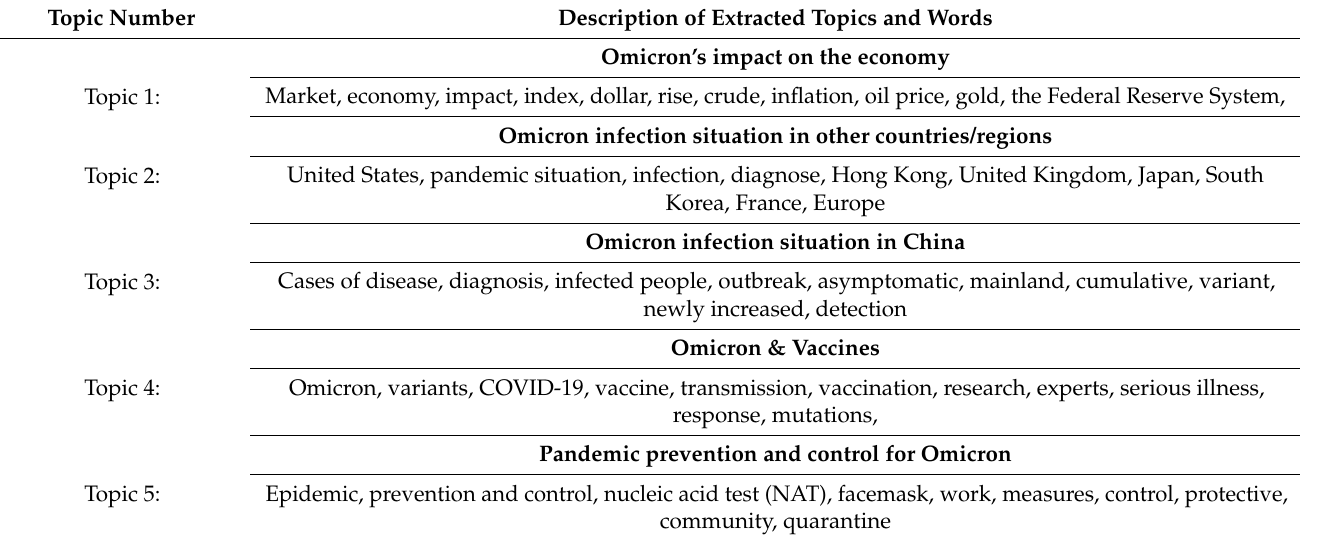
Table 2. Topics extracted from Weibo related to